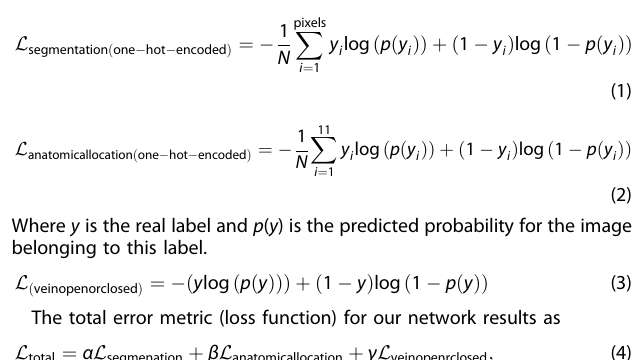
algorithm training data and Table 8 for the internal validation data. Annotations include manual delineations of vein and artery cross sections